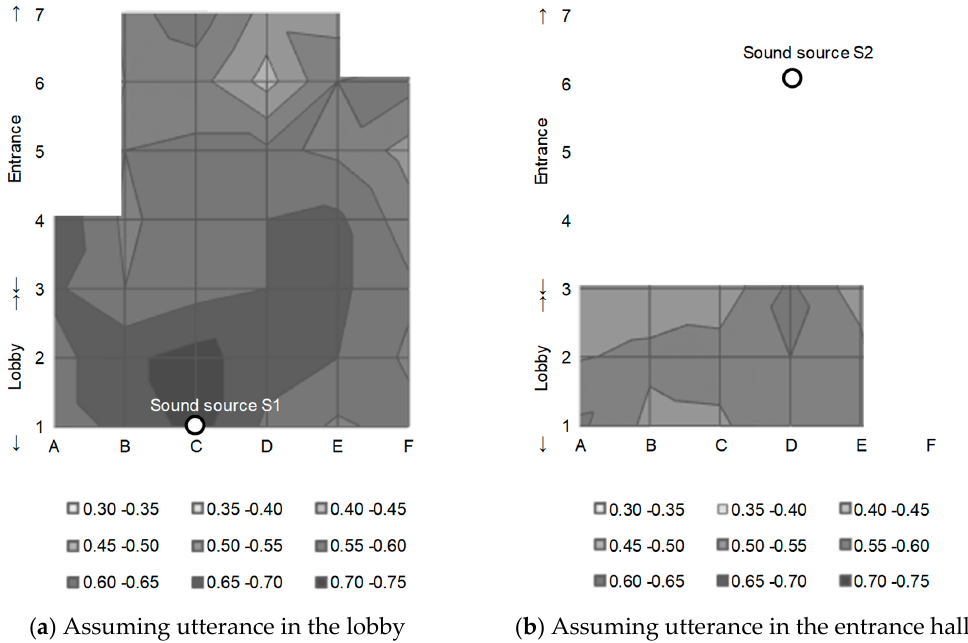
Figure 10. Distribution of intelligibility in the room: ( a ) assuming an utterance in the lobby and ( b ) assuming an utterance in the entrance hall.